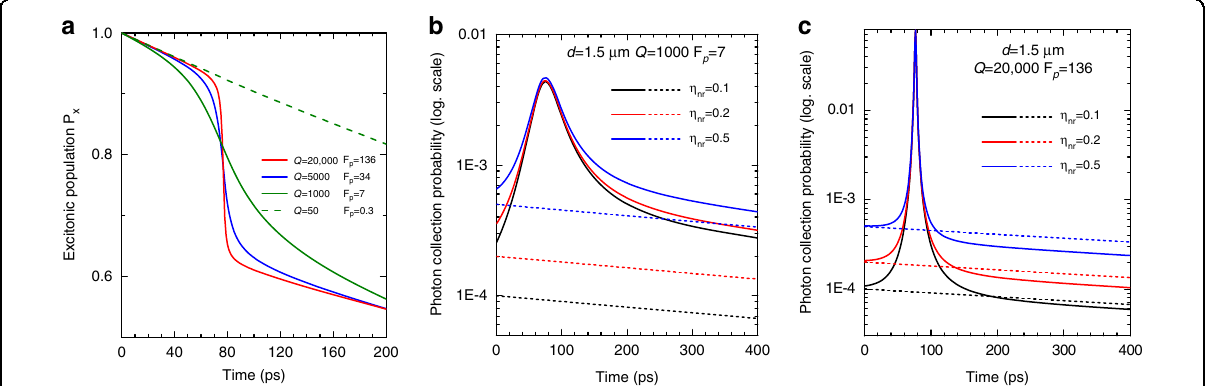
Fig. 5 Rate equation modelling of on-off Purcell switching for a single QD in a QDM. a Time-dependence of the excitonic population in the QD for four different sets of ( Q , F p ) cavity mode fi gures of merit. b , c Solid lines show the evolution of the photon collection probability per pulse and per ps in log scale (this quantity is proportional to the PL signal in experiments) for a moderate -Q (1000 for b ) and a high- Q (20,000 for c ) pillar mode. We consider three different values of η , ranging from 0.1 to 0.5. Dashed lines show the result for a reference emitter that would experience a negligible nr Purcell